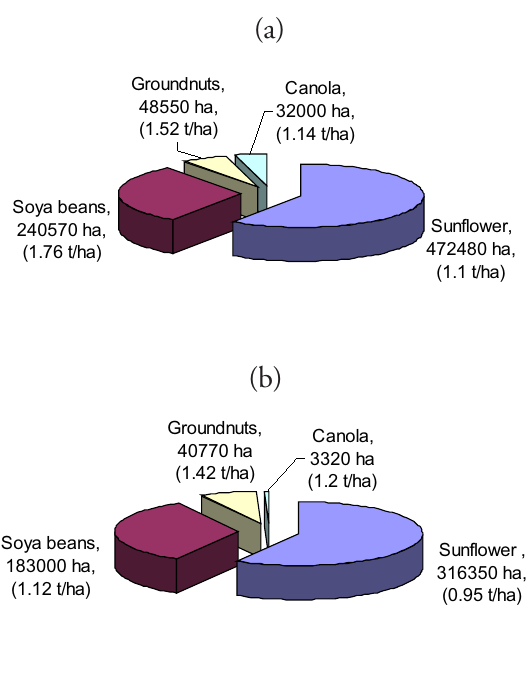
Figure 1. SA’s oilseed production for (a) 2005/06 and (b) 2006/07 showing area planted (ha) and yield (t/ha). Source: CEC,